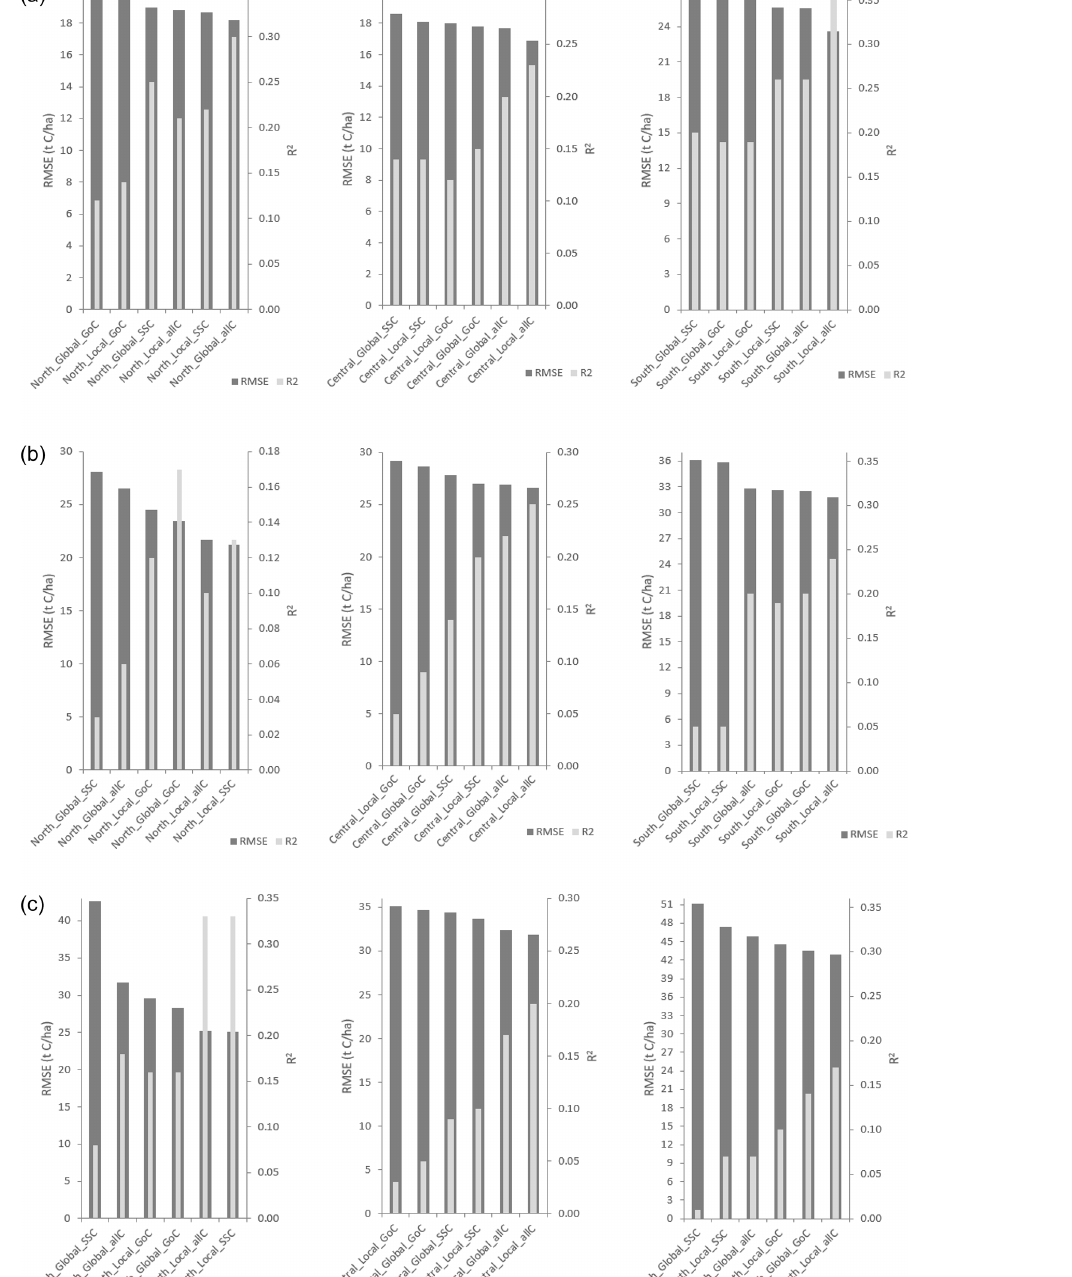
Figure 2. Local and global models ranked by decreasing RMSE per sub-area and category of variables along with corresponding R 2 ( a – litter layer; b – mineral soil layer; c – total soil layer; SSCs – site-specific covariates; GoCs – group of covariates; allCs – all